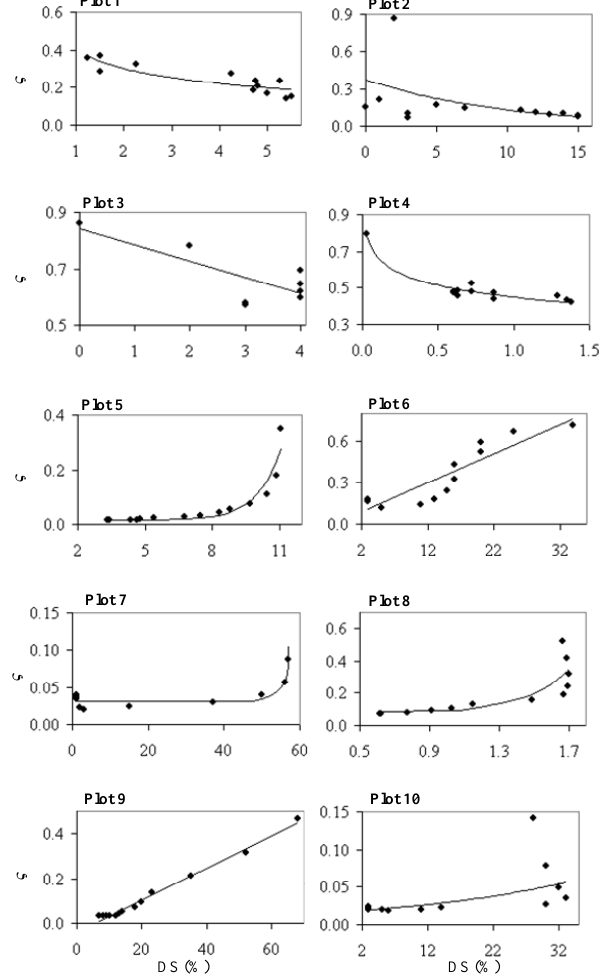
Fig. 6. Intra-plot time-serial relations between the estimated DS and the runoff ( ζ ) coefficient.